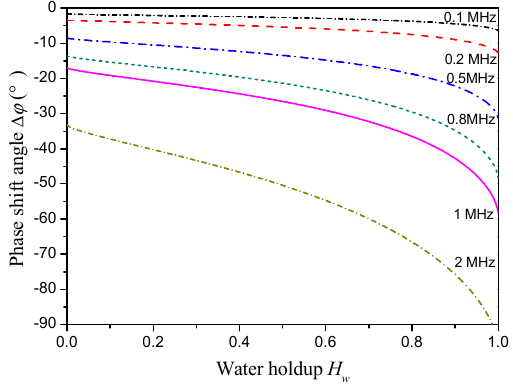
Figure 8. Phase shift responses of the CCS with different exciting frequencies. Figure 9a–c show the phase shift responses of the CCS with different electrode angles, electrode lengths, and pipe wall thicknesses for the ST flow pattern. The variation range of the phase shift indicates an increasing tendency with the increase in the electrode angle θ and the electrode length l , but a decreasing tendency with the increase in the pipe wall thickness δ . It should be noted that for a circular pipe cross section, a larger electrode angle can produce an obvious edge effect, and a longer electrode length can lead to low detection sensitivity for small-scale flow structures. Therefore, in this study, the electrode angle θ is selected as 120° and the electrode length l is selected as 60 mm. Since the pipe should be strong enough to avoid damage in the flow loop test, the pipe thickness δ is selected as 5 mm. The shield electrodes use the same geometrical parameters as the exciting and measuring electrodes. ( a ) ( b ) ( c ) Figure 9. Phase shift responses of the CCS with different geometric parameters. ( a ) With different electrode angles; ( b ) with different electrode lengths; ( c ) with different pipe wall thicknesses.